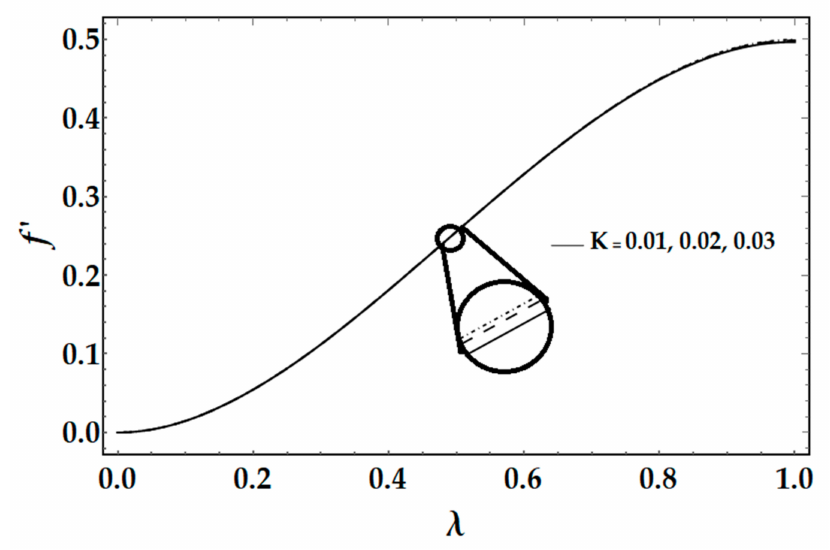
Figure 3. Implications of K on velocity distribution (axial) f (cid:48) ( λ )